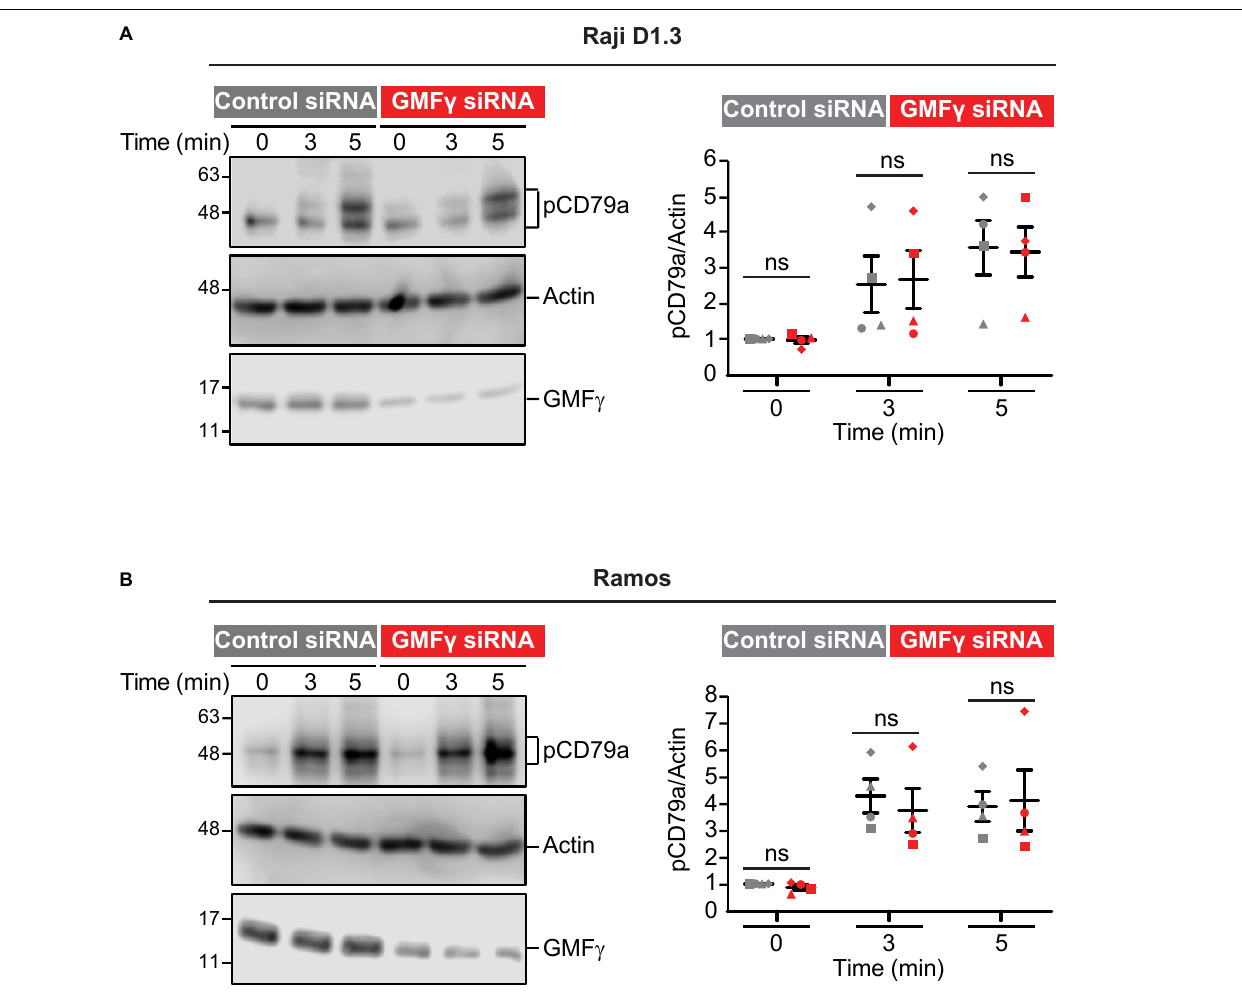
FIGURE 7 | Depleting GMF γ does not impair CD79 phosphorylation induced by soluble anti-Ig antibodies. Cells were transfected with either control siRNA or GMF γ siRNA. (A) Raji D1.3 B cells were stimulated with 20 µ g/mL goat anti-mouse IgM to initiate signaling through the D1.3 BCR. (B) Ramos B cells were stimulated with donkey anti-human IgM. Cell lysates were analyzed by immunoblotting with antibodies that recognize the phosphorylated CD79a ITAM (pCD79a), actin (loading control), or GMF γ . The left panels show a representative experiment. The right panels show results from 4 independent experiments. For each sample, the pCD79a band intensity was divided by the corresponding actin band intensity (loading control). The resulting ratios were normalized to that for the 0 min control siRNA cell sample (defined as 1.0) in the same experiment. On the graph, each of the four experiments is indicated by a different symbol. The bars show the mean ± SEM. Paired t -tests were used to calculate p -values. ns, not significant ( p >